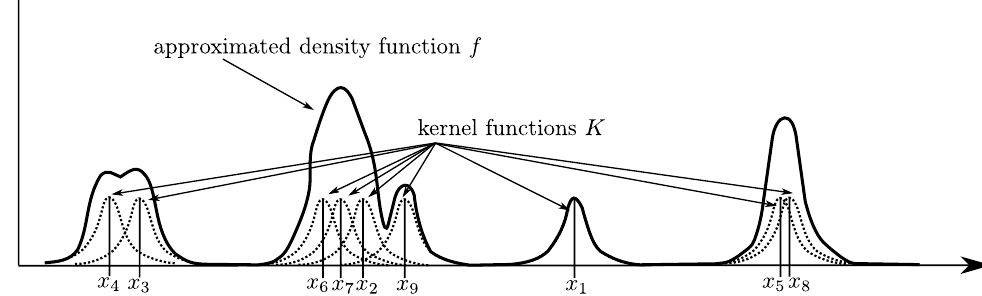
Figure 2. Schematic representation of approximating a density function from measurements by utilizing kernel density estimation